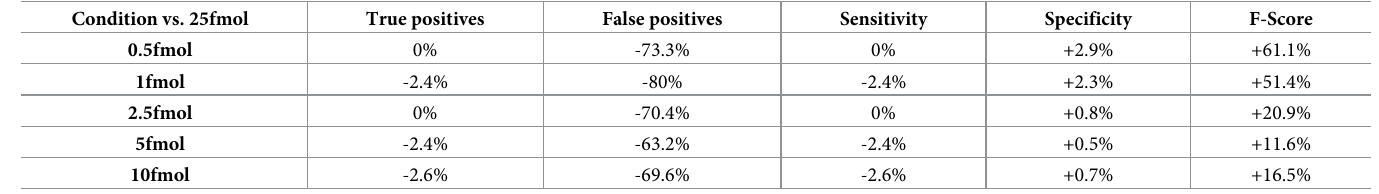
Table 5. Performance of the mi4p methodology (with the aggregation step) expressed in percentage with respect to DAPAR workflow, on Saccharomyces cerevisiae + UPS1 experiment, with at least 1 out of 3 quantified values in each condition. Missing values were imputed using the Maximum Likelihood Estimation method. Condition vs.